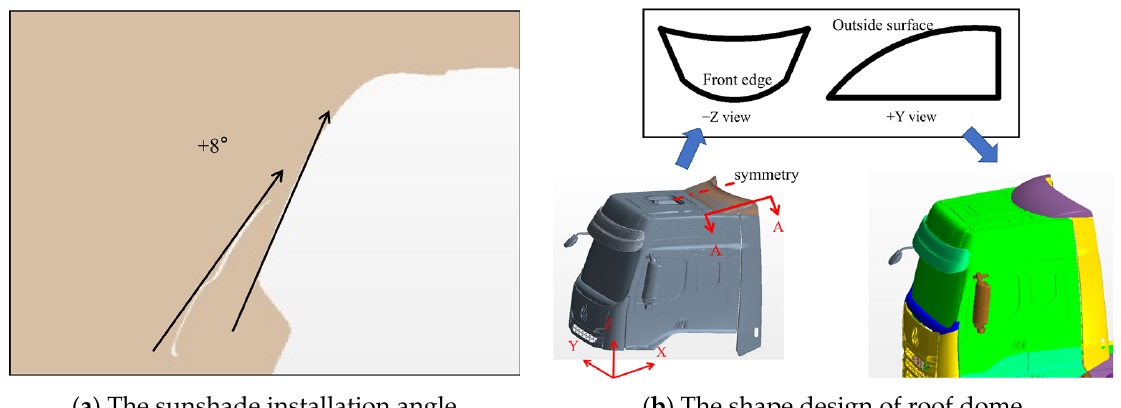
Figure 11. Optimal design of cab accessories.